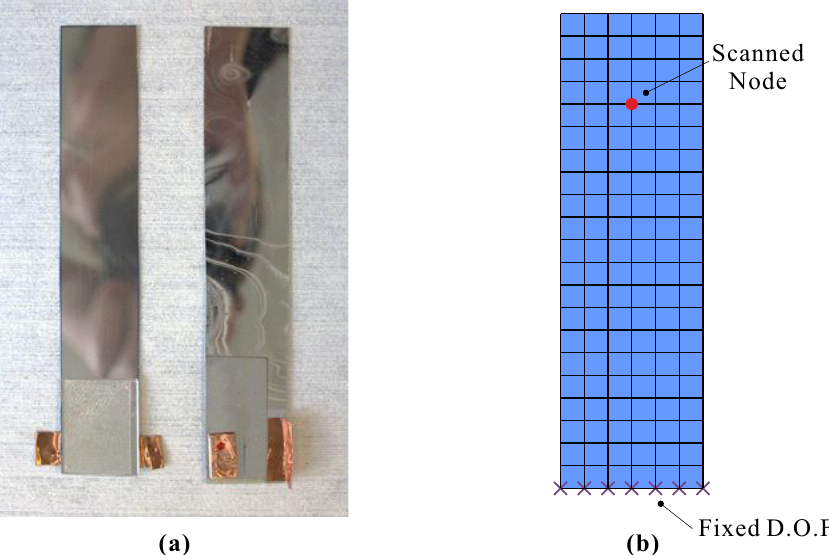
Figure 3. ( a ) Rectangular sample of PET/PVDF-TrFE used in the estimation of the piezoelectric constant d 31 . ( b ) Finite Element model of the cantilever plate.